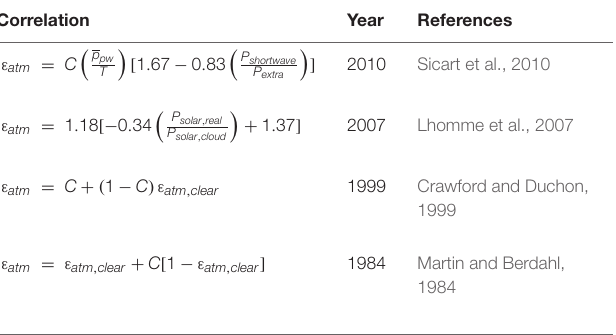
TABLE 2 | Proposed correlations for the average atmospheric emissivity in a cloudy sky. Correlation